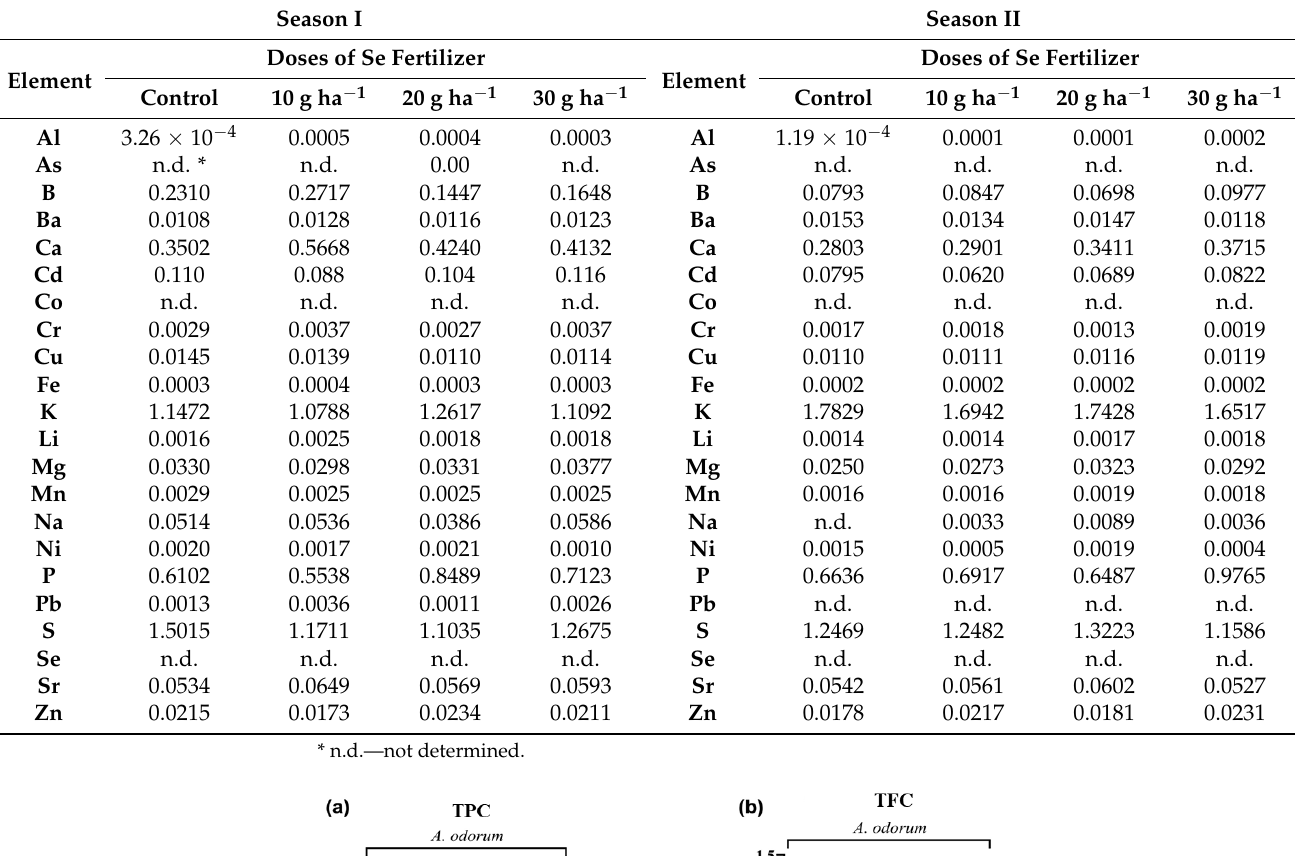
Table 3. Bioaccumulation factor (BAF) values for biogenic elements in the leaves of A. odorum for both seasons.